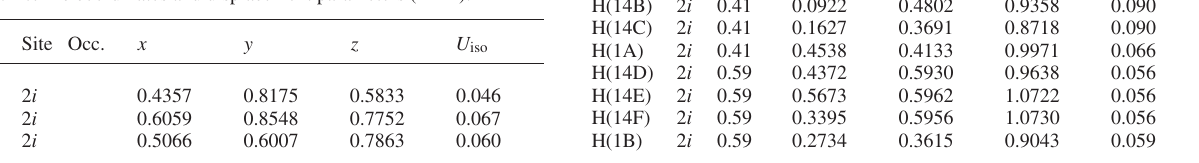
Table 2. Atomic coordinates and displacement parameters (in Å 2 ) .